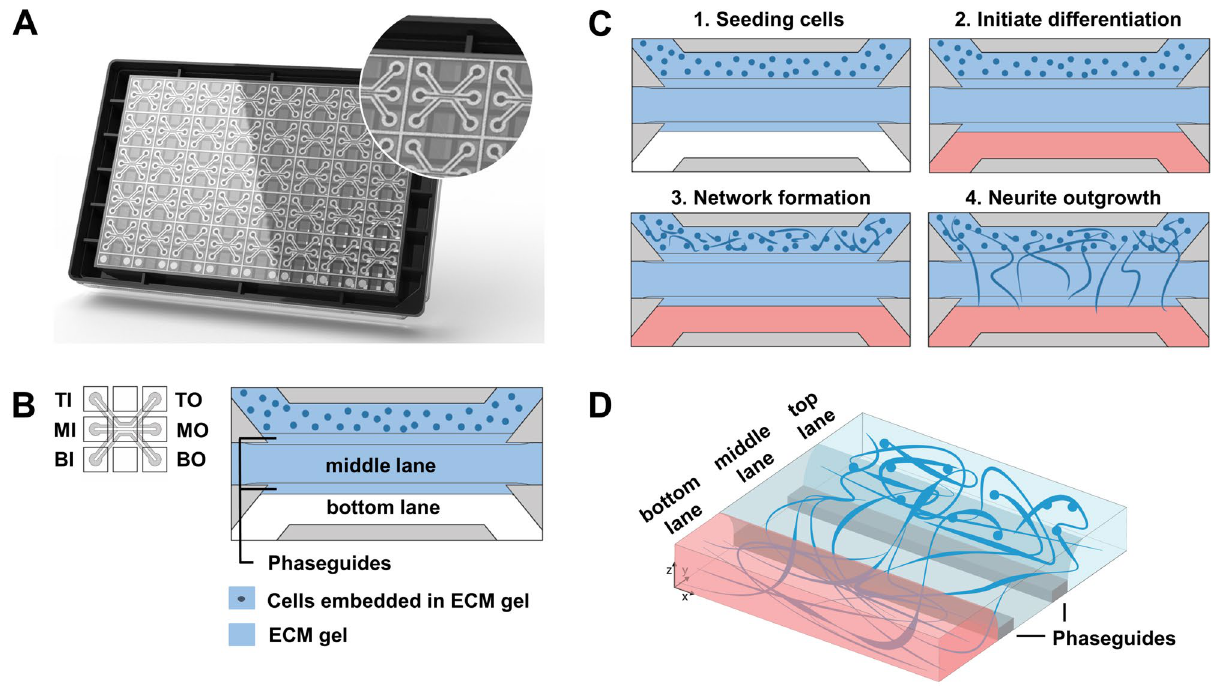
Figure 1. Motor neuron progenitors form 3D networks in the OrganoPlate. ( A ) Image of an OrganoPlate 3-lane. The OrganoPlate is a microfluidic platform based on a 384-well plate design containing 40 individual tissue culture chips. The image is copyright of MIMETAS BV. ( B ) Each tissue culture chip contains 3 microfluidic lanes that join in the center of the chip. The 3-lane architecture in the chips’ center is assured by phaseguides that enable patterning of extracellular matrix gel. Inlet and outlet wells allow access to each lane: top inlet (TI) and top outlet (TO) wells allow access to top lane; middle inlet (MI) and outlet (MO) wells to middle lane; and bottom inlet (BI) and outlet (BO) wells to the bottom lane. Matrigel-GFR without cells is added to the middle lane. Following gelation, motor neuron progenitors embedded in matrigel-GFR are seeded in the top lane. ( C ) Schematic overview of cell seeding procedure. Matrigel-GFR is seeded in the middle lane and MNPs embedded in matrigel-GFR are seeded in the top lane (panel 1). MNPs form networks in the top lane (panel 2), after which neurites protrude into the middle and eventually bottom lane (panel 3). Blue color indicates presence of gel, red color indicates presence of medium. ( D ) Schematic overview of the spatial segregation of motor neuron somata (top lane) and axons (middle and bottom lanes) in OrganoPlate 3-lane Neurites penetrating the middle lane were mostly TAU-positive, while only some neurites contained MAP2 (Fig. 2C). These results indicated that the neurites protruding the adjacent lane were predominantly axonal. Finally, we assessed spontaneous calcium fluctuations as an indication of electrophysiological activity. The calcium-sensitive dye Cal-520 AM was loaded into the cells, after which intracellular calcium fluctuations were detected using high-speed imaging (Supplementary Video S1). The videos show spontaneous calcium fluctua- tions confirming that the neurons are electrophysiologically active. Overall, these data show that differentiated motor neuron progenitors are mature, electrophysiologically active, and send their axons into the middle lane of the tissue culture chip. Neuronal network formation and quantification of axon outgrowth. Motor neurons send their axons over long distances to connect with their target cells, and changes in motor axon projections are a hall- mark of motor neuron disease. Thus, as axon outgrowth and morphology are important parameters, we investi- gated our ability to quantify axon outgrowth in the OrganoPlate. MNPs seeded in the OrganoPlate formed neu- ronal networks in the top lane only during the first 6 days, after which they started to protrude their processes into the middle lane (Fig. 3A). This network became increasingly complex over time, where axons eventually penetrated into the bottom lane (Fig. 3A, Supplementary Fig. S2). Interestingly, the addition of 10 ng/mL brain- derived neurotrophic factor BDNF to the bottom lane increased cell migration into the middle lane (Supplemen- tary Fig. S2). Moreover, upon filling the middle lane with a collagen-I ECM, axon outgrowth was substantially reduced (Supplementary Fig. S3). These observations indicate that specific molecular changes affect the behavior of motor neurons and axons in the OrganoPlate. To quantify the outgrowth, the raw signal from the middle lane (region of interest, ROI) was converted into a binary image where black signal indicates the presence of live cells and processes. The black signal was then skeletonized, after which total axon length was extracted (Fig. 3B). As expected, total axon outgrowth increased over time (Fig. 3C). Axon outgrowth was significantly increased at day 14 (P = 0.0003) and 17 (P < 0.0001) when compared to day 6. For situations of abundant outgrowth, an alternative quantification approach may be employed where black signal is quantified directly as a percentage of